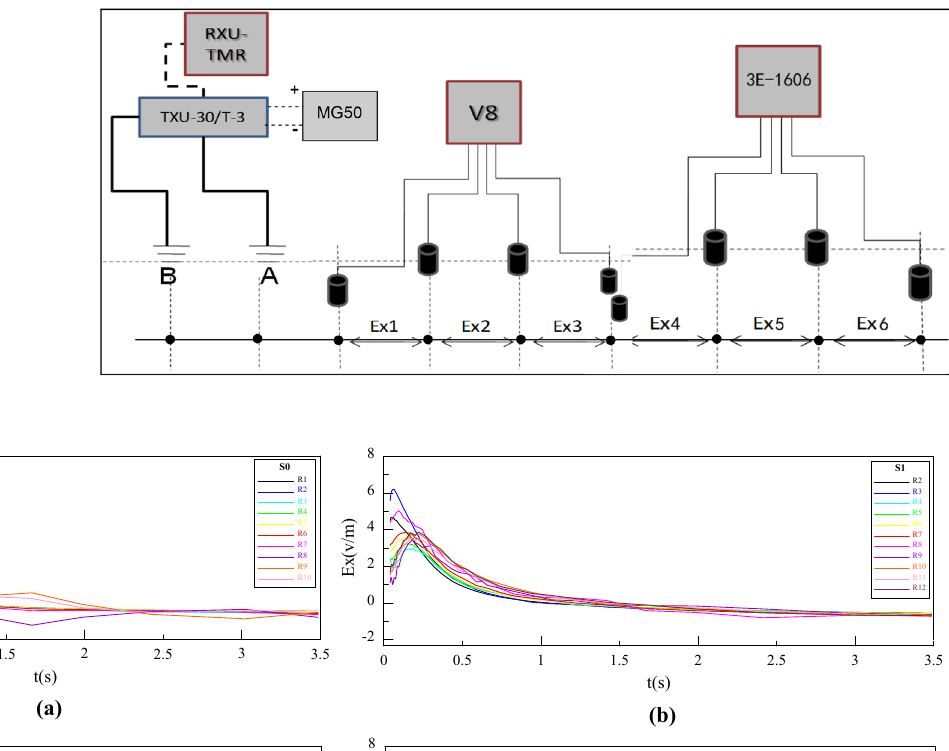
Fig. 7 Layout for MCSEM with V8 multi-functional electromag- netic exploration system